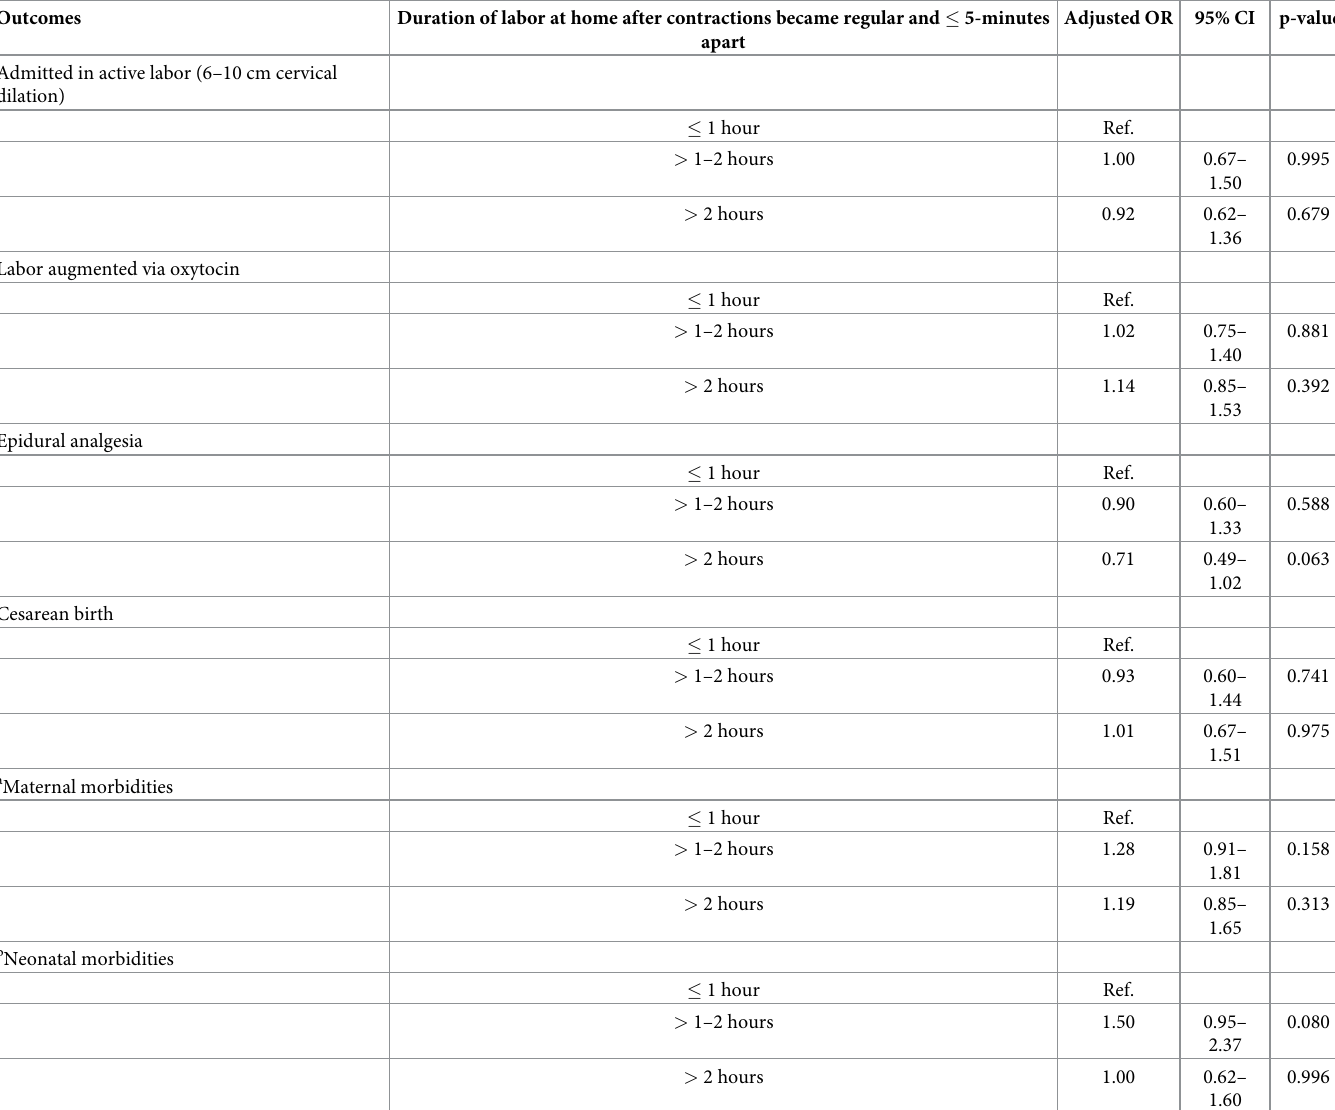
Table 4. Associations between labor duration at home after contractions had become regular and � 5-minutes apart and the six study outcomes (n = 1,082).